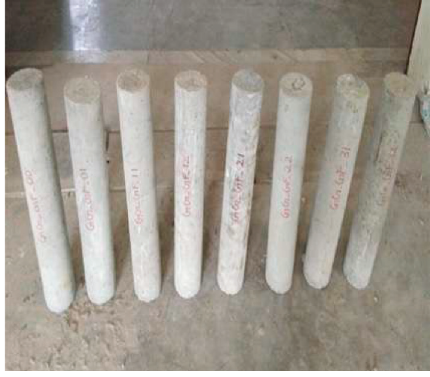
Figure 8: Columns’ specimens.